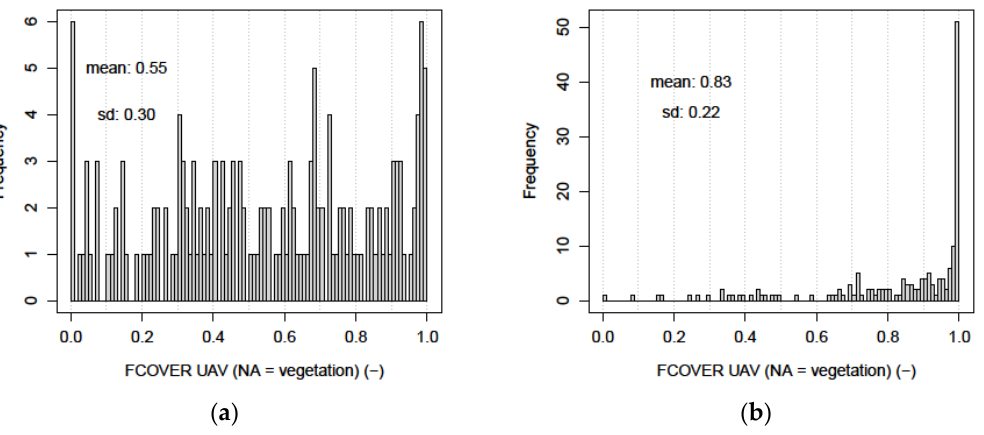
Figure 4. Value distributions of FCOVER-UAV NA=veg across the study site for ( a ) the spring and ( b ) summer acquisition dates. FCOVER was derived on the basis of S2 pixels.